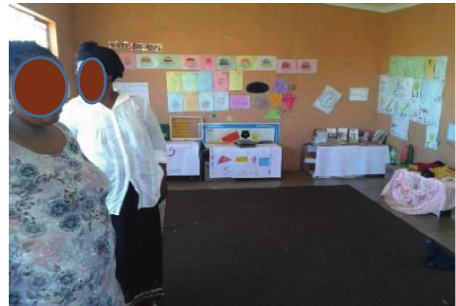
Figure 16: The ECD supported by parents: site three.